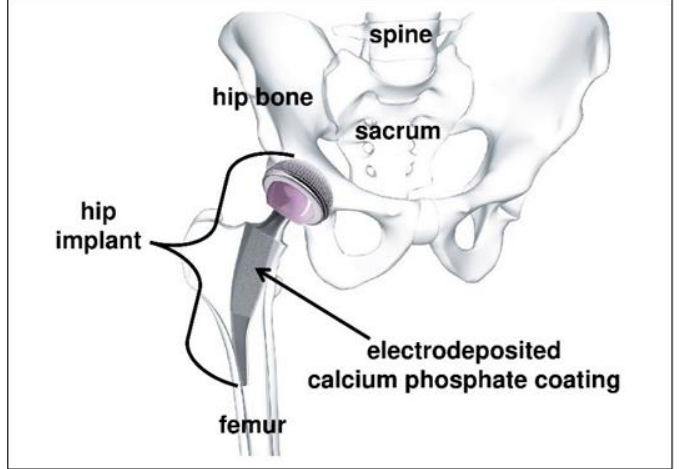
Figure 1. Industrial calcium phosphate coating electrodeposited on titanium hip implant. Reprinted and adapted with permission from Aesculap — BBraun Gmbh.